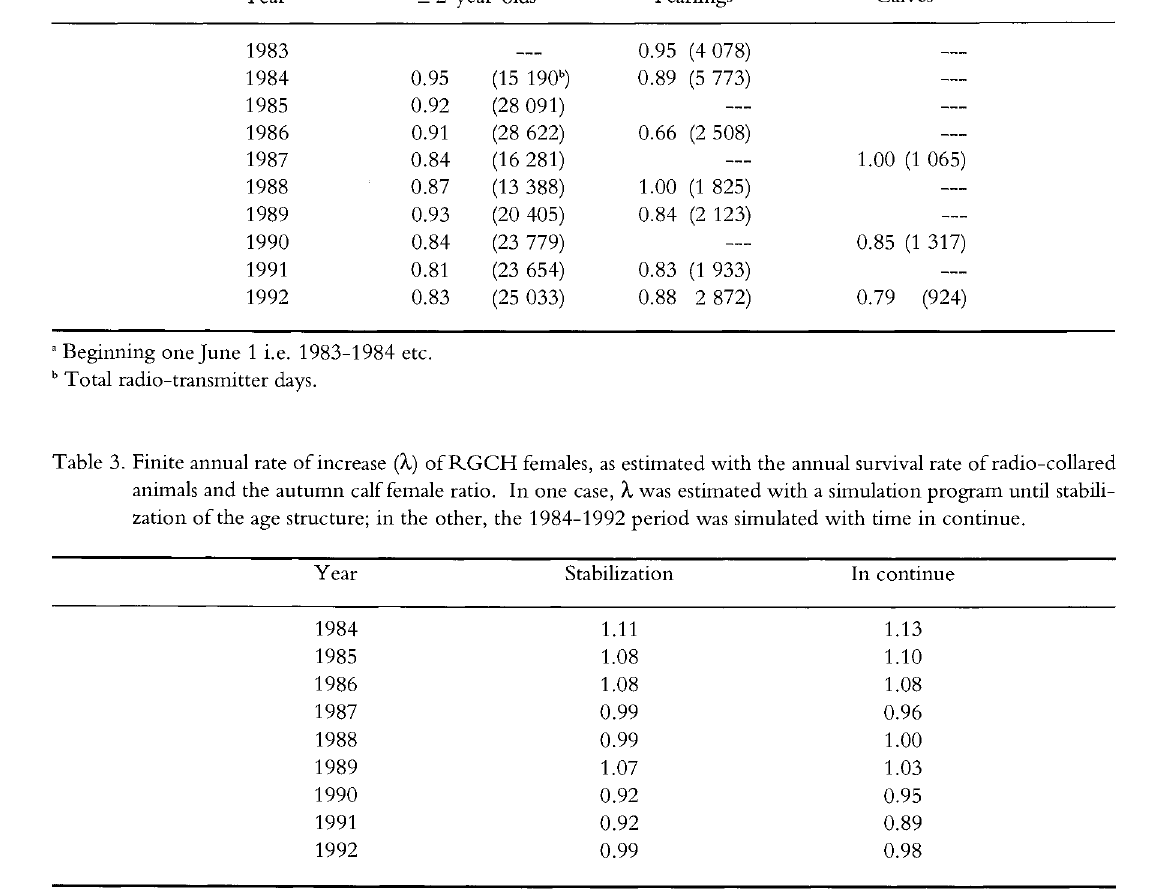
Table 4. Relative contribution (%) of productivity and survival in the decrease of X for the females of the R G CH during the period 1984-1992, in comparison to 1983, when X —